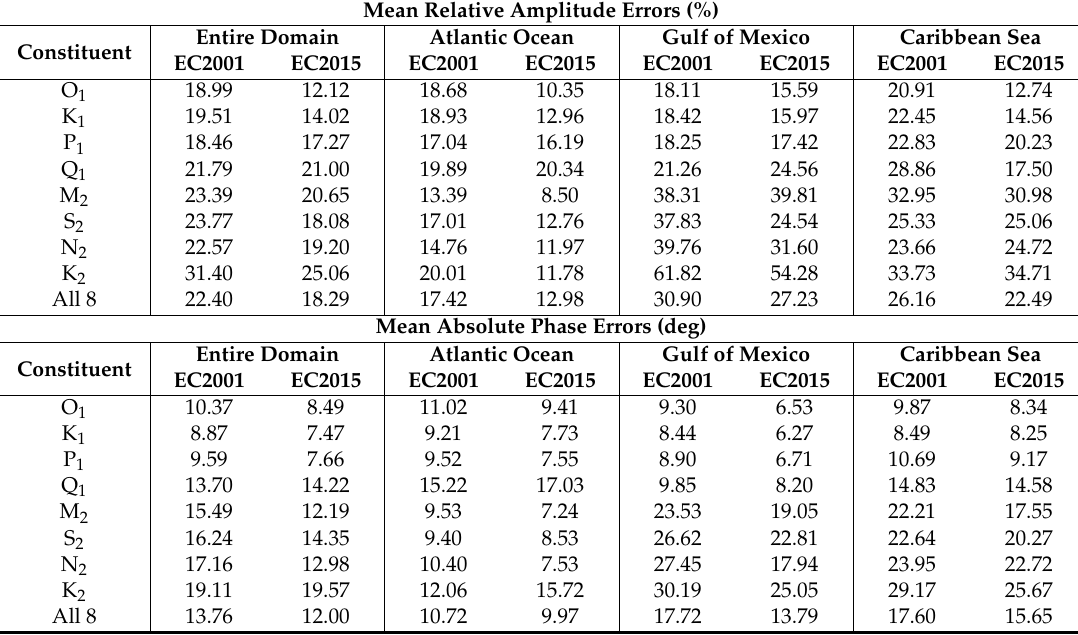
Table 7. Comparison of mean relative amplitude and mean absolute phase errors by region for each of the eight primary harmonic constituents and summed over all eight constituents for the EC2001 and EC2015 tidal databases: only common 367 wet validation stations used in the summations.